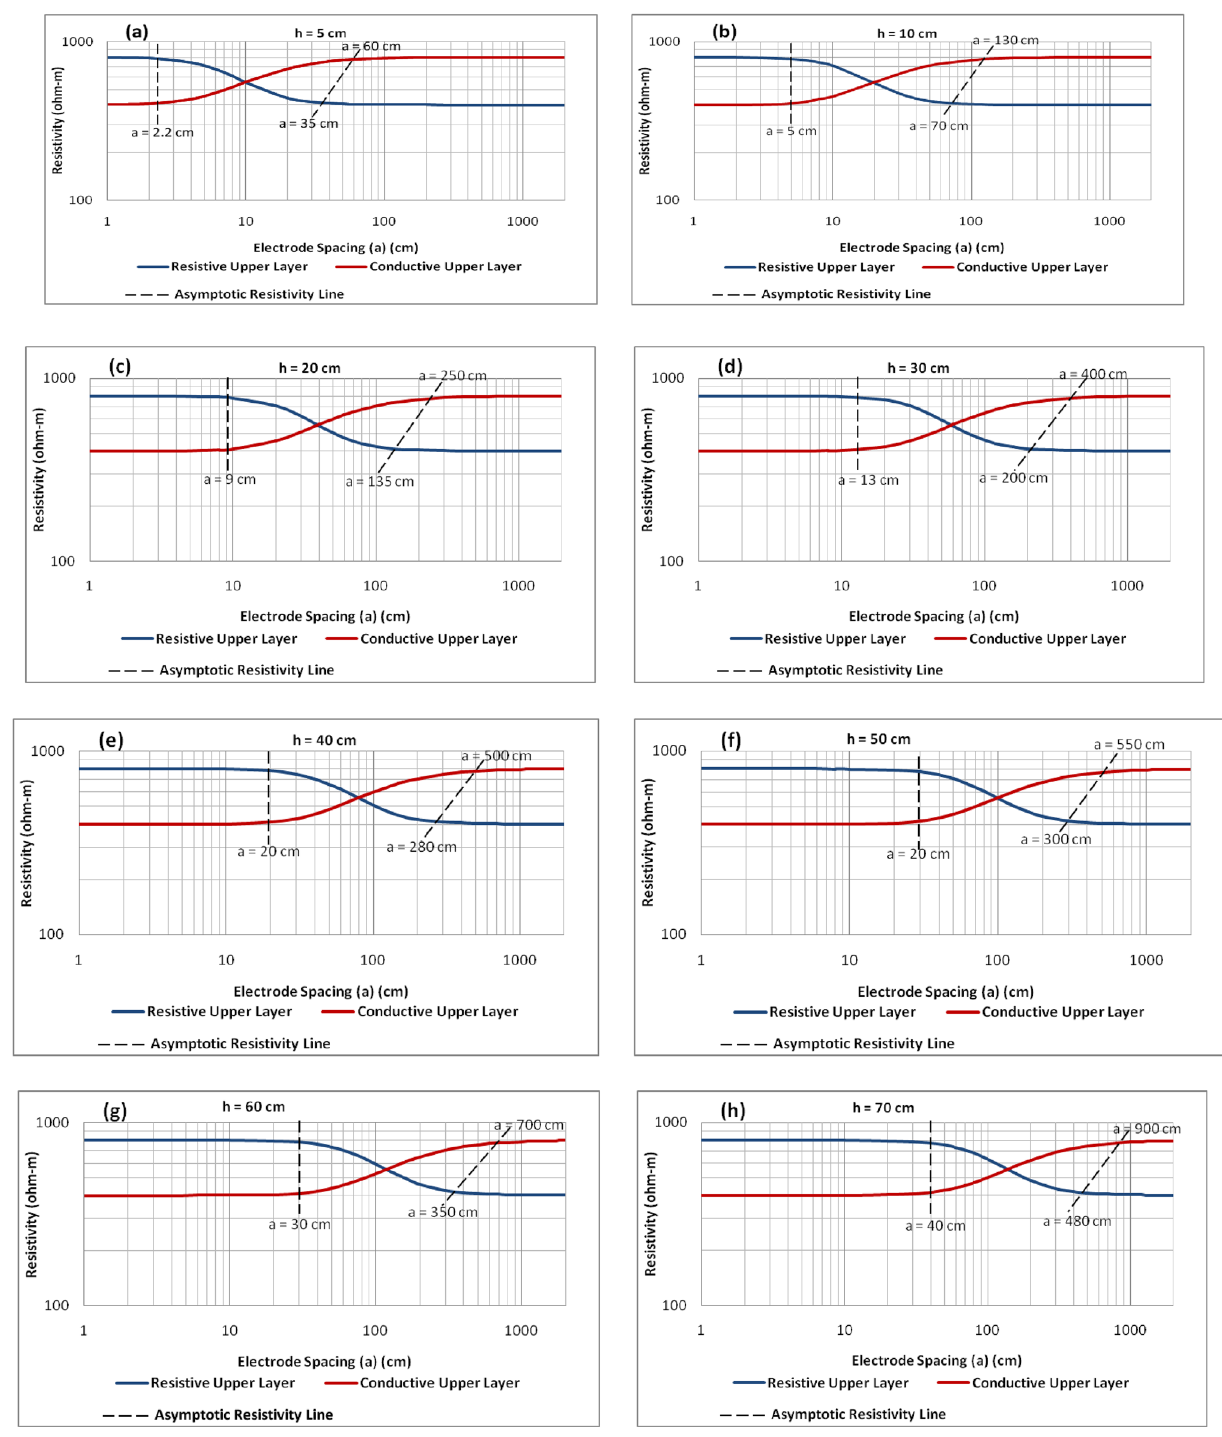
Fig. 4 Simulated curves. ab h = 5 cm, b h = 10 cm c h = 20 cm; d h = 30 cm; e h = 40 cm; f h = 50 cm; g h = 60 cm; h h = 70 cm; i h = 80 cm; j h = 90 cm k h = 100